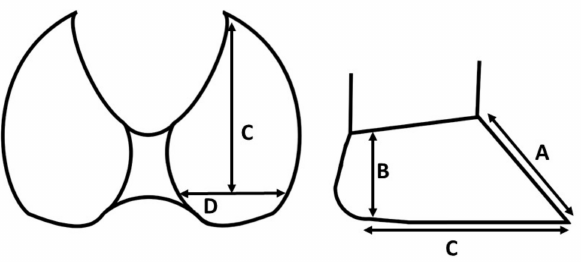
Figure 1. Schematic representation of the claws from plantar and lateral with the measurements: A = toe length, B = heel height, C = sole length, D = sole width.